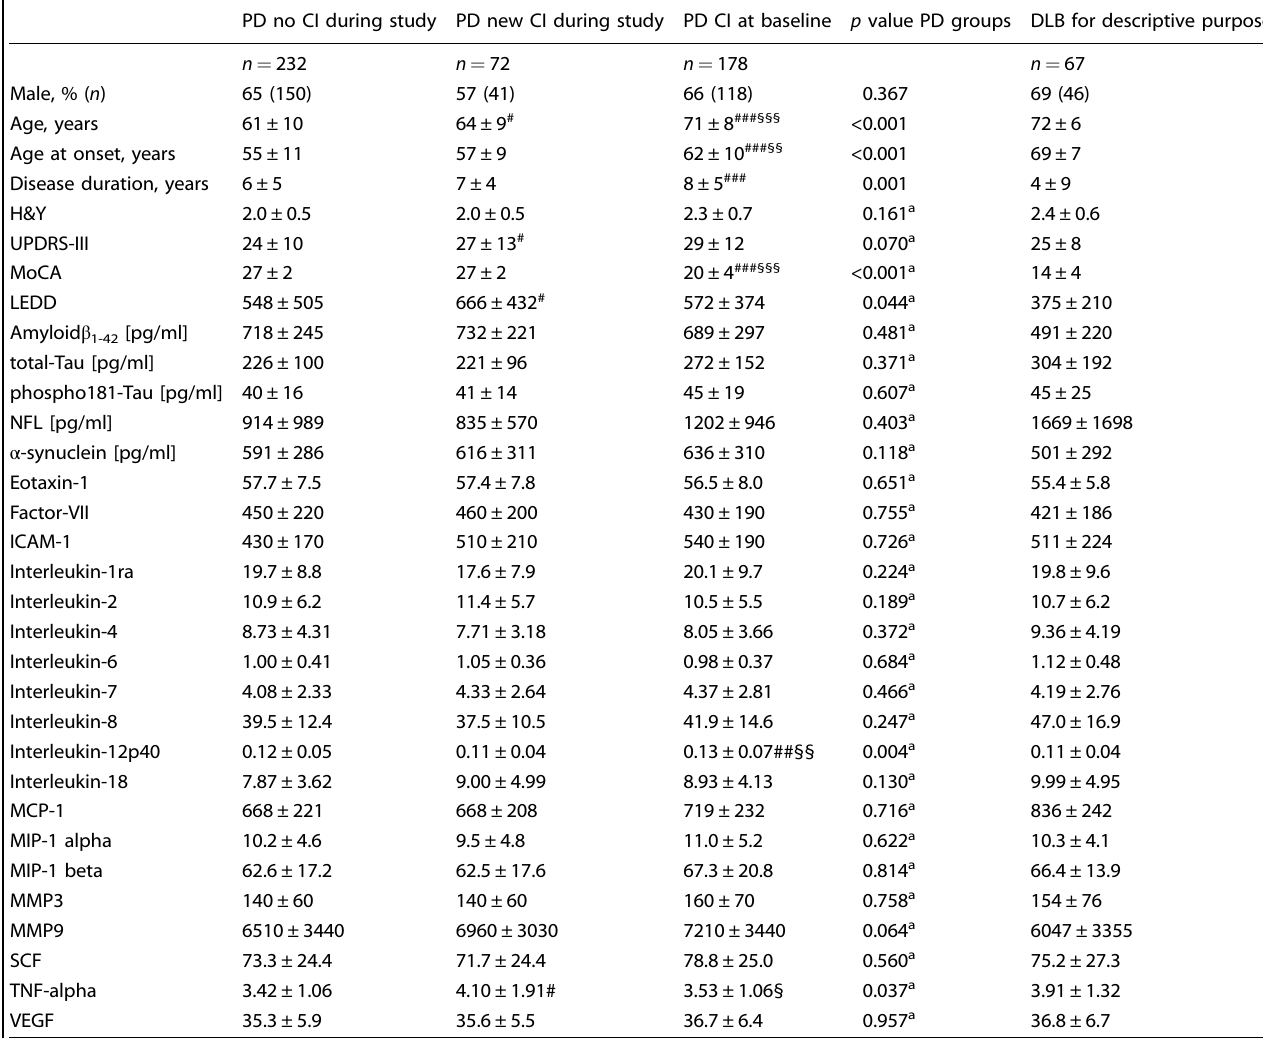
Table 5. Baseline demographic, clinical and in fl ammatory data from all people with Parkinson´s disease strati fi ed by cognitive